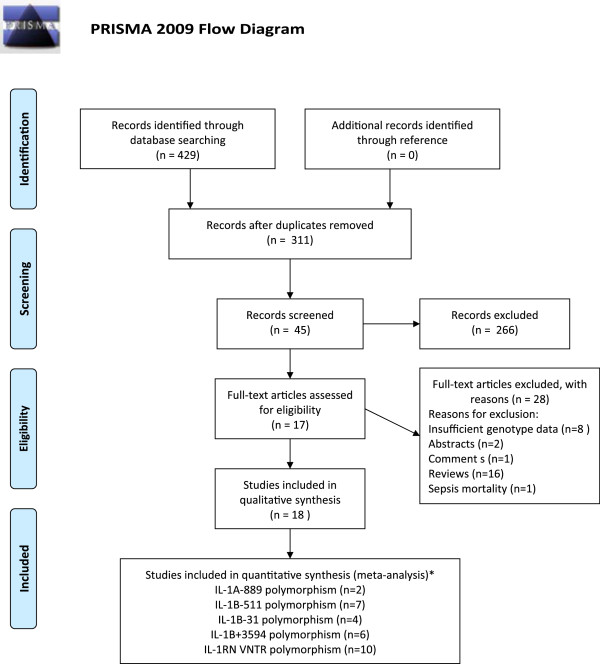
Flow of study identification, inclusion, and exclusion. *represents that certain studies will appear in more than one group when they are divided by polymorphism.